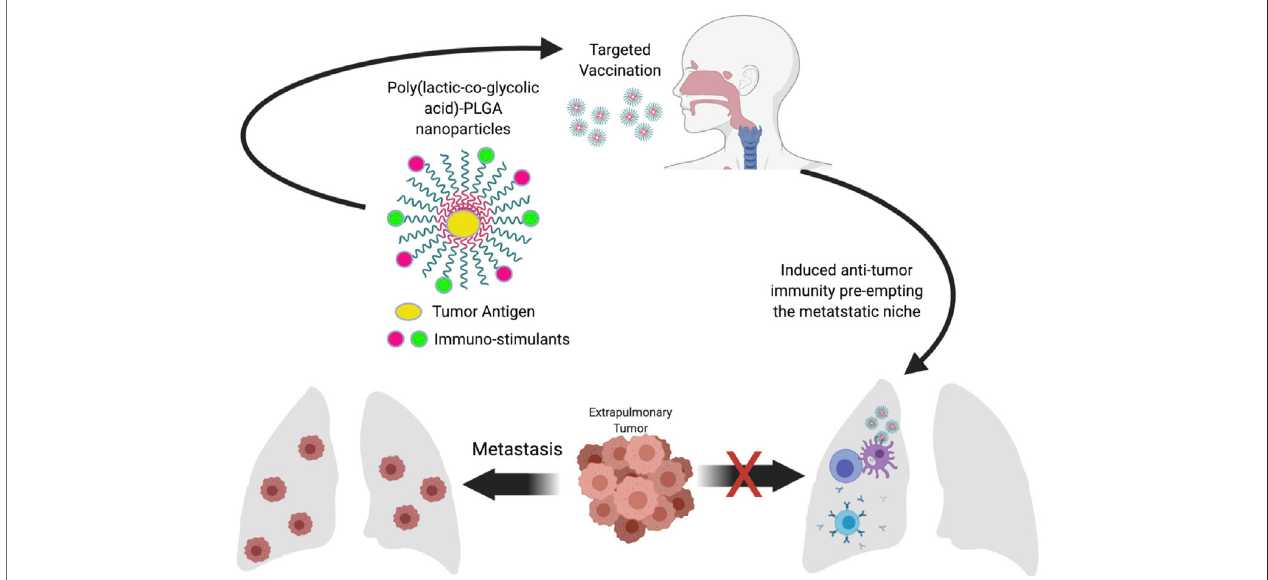
FIGURE 2 | Conceptual framework. Pulmonary administration of immunostimulant coated nanoparticles encapsulating tumor antigens induced lung speci fi c anti- tumor immunity capable of forestalling immunosuppression by the premetastatic niche leading to the ability of immunosurveillance mediated by cytotoxic T-cells and antibodies to clear disseminated tumor cells and prevent the colonization of the lung by the existing extra-pulmonary tumor.